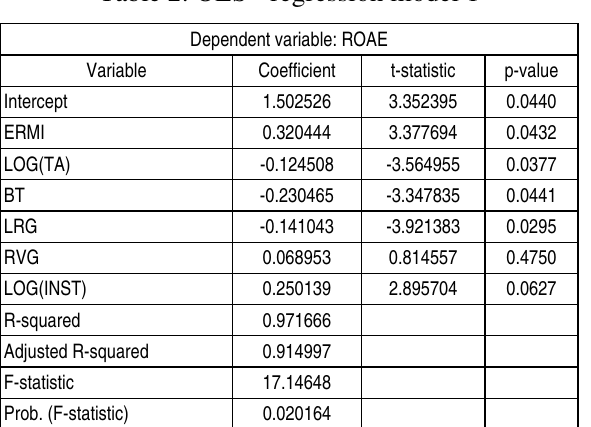
Table 2 . OLS - regression model 1